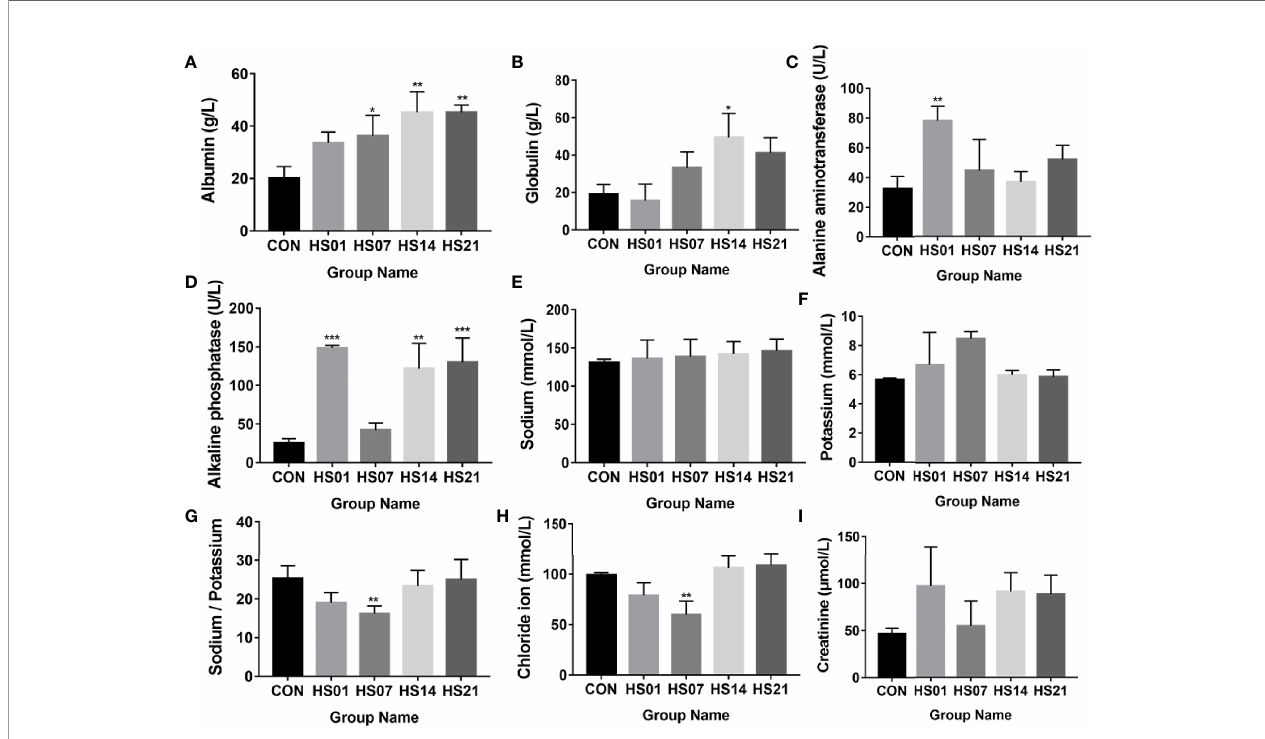
FIGURE 1 | Effect of HS on the biochemical indexes of pig serum. CON indicates no heat stress group of day 1, HS1, 7, 14, 21 indicate heat stress day 1, 7, 14, and 21 groups respectively, n = 6; "*" indicates p < 0.05, "**" indicates p < 0.01, "***" means p < 0.001. (A) albumin; (B) globulin; (C) alanine aminotransferase; (D) alkaline phosphatase; (E) sodium ion; (F) calcium ion; (G) calcium to sodium ratio; (H) chloride ion; (I)